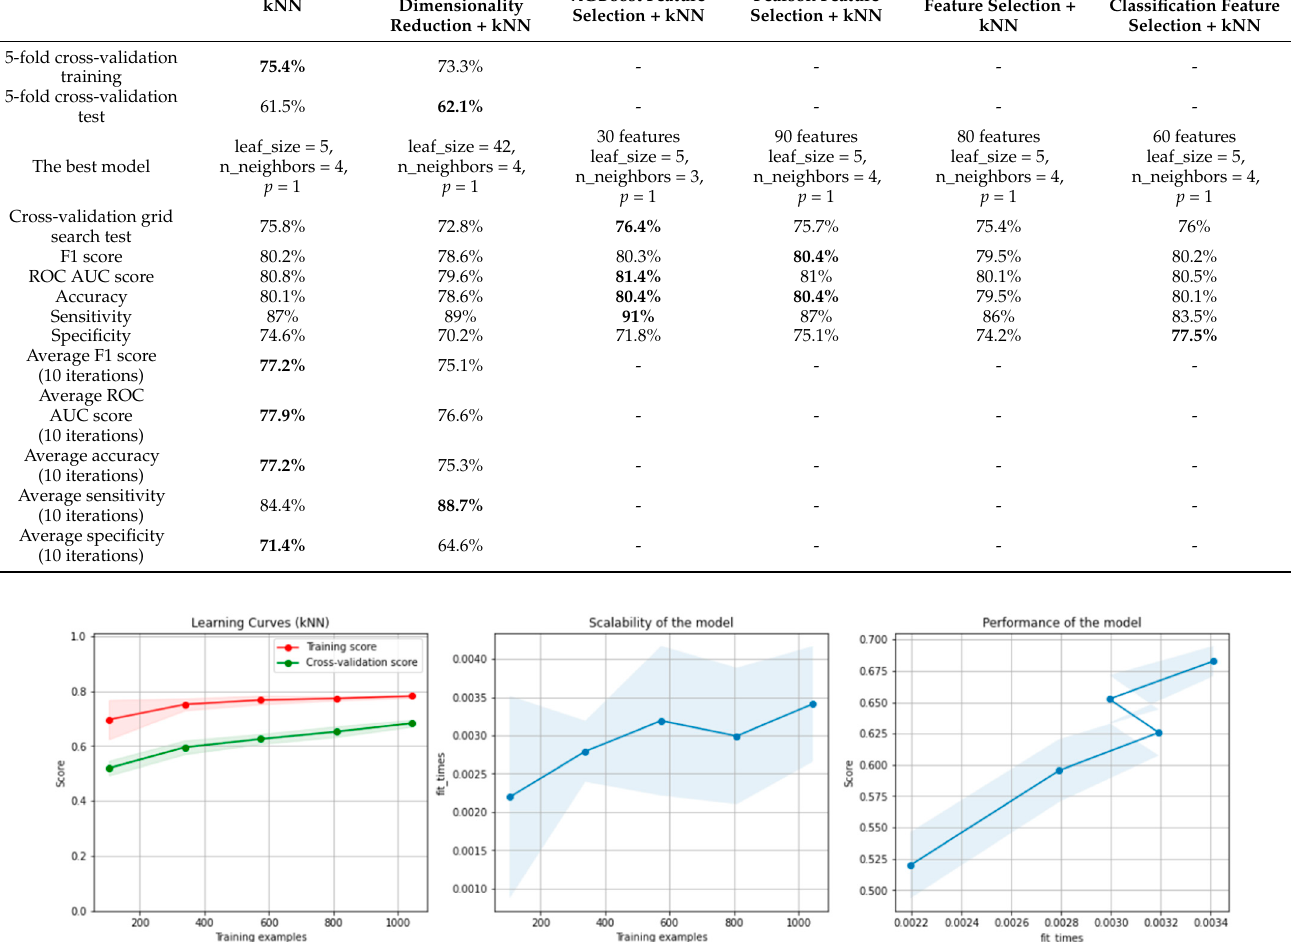
Figure 9. Learning curves, scalability and model performance for the RF algorithm, for the non-overlapping dataset. Table 3. Results of the kNN algorithm applied on the non-overlapping dataset. The highlighted values represent the highest scores obtained.